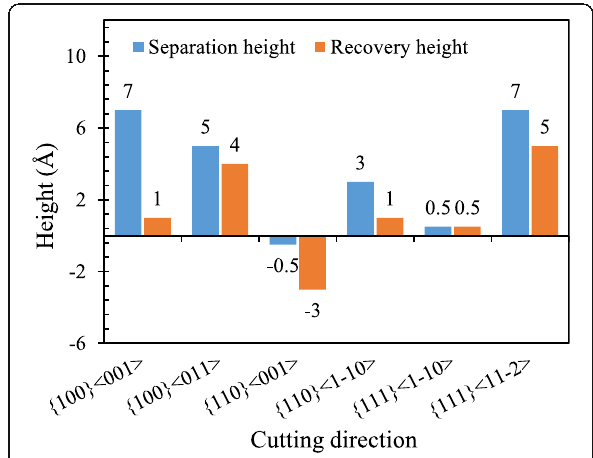
Fig. 12 Separation height and recovery height at different cutting direction with 5 nm